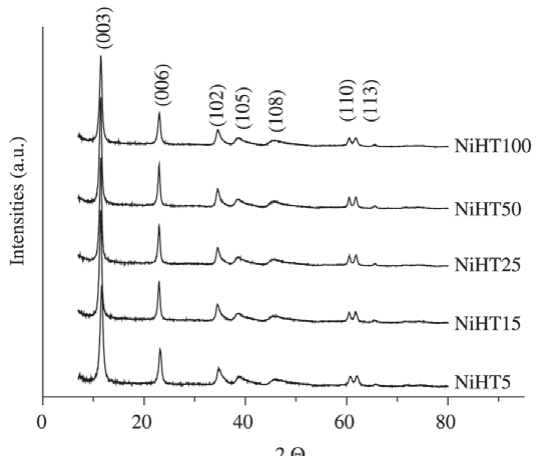
Figure 1 . X-ray diffractograms for the as-synthesized Ni, Mg, Al-HTLC samples.